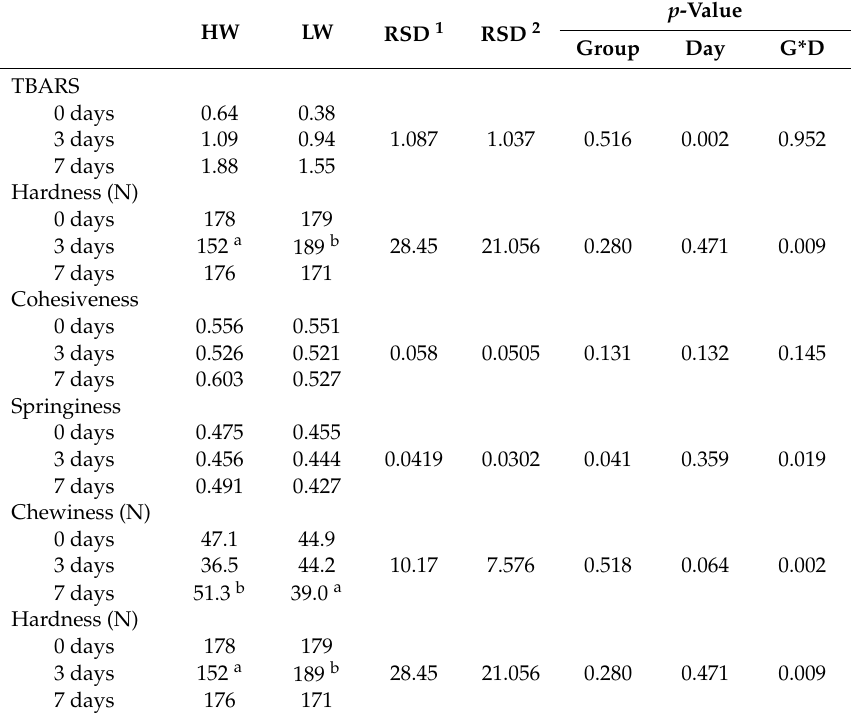
Table 7. TBARS ( µ g MDA g − 1 ) and texture profiles of meat samples (M. longisimus lumborum ) after 0, 3 or 7 days of refrigerated storage (ageing) and subsequent cooking in lambs born with high (HW) or low weight